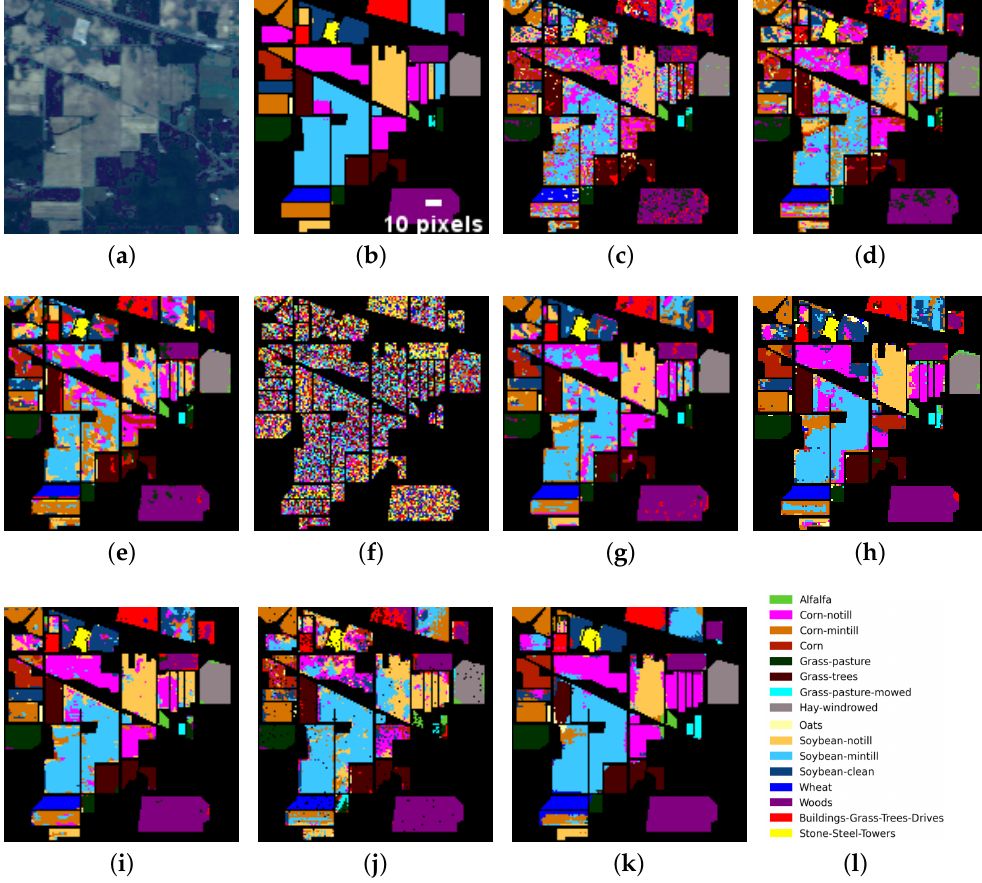
Figure 7. The classification maps for the IP with compared methods. ( a ) Source Image. ( b ) Ground Truth. ( c ) SVM. ( d ) 2D-CNN. ( e ) 3D-CNN. ( f ) HSI-BERT. ( g ) CA-GAN. ( h ) DCFSL. ( i ) VSCNN. ( j ) S-DMM. ( k ) Our proposed method. ( l )